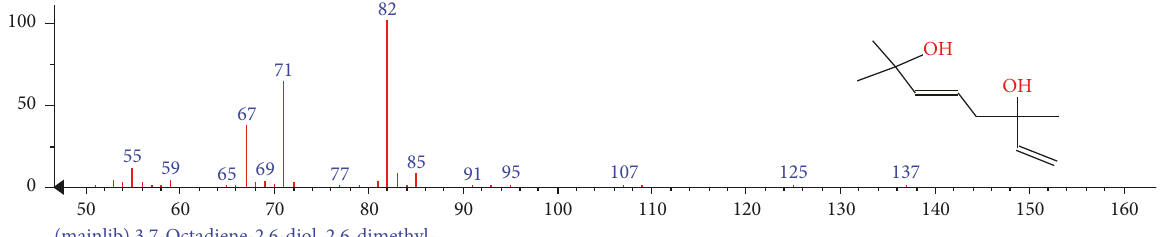
Figure 15: Mass spectrum of compound 3,7-octadiene-2,6-diol, 2,6-dimethyl- of whole plant hexane fraction of Achillea wilhelmsii (WHFAW).